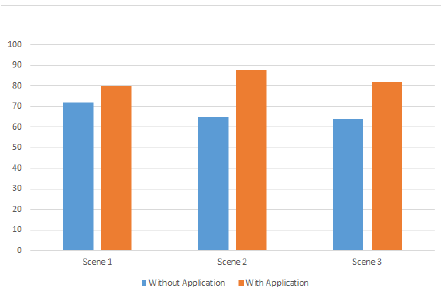
Figure 50. Comparison of average score between with/without using our